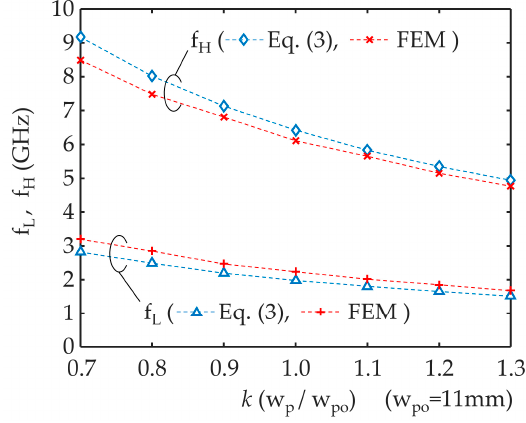
Figure 6. Analysis of the w p effects on the low- and high-cutoff frequencies.